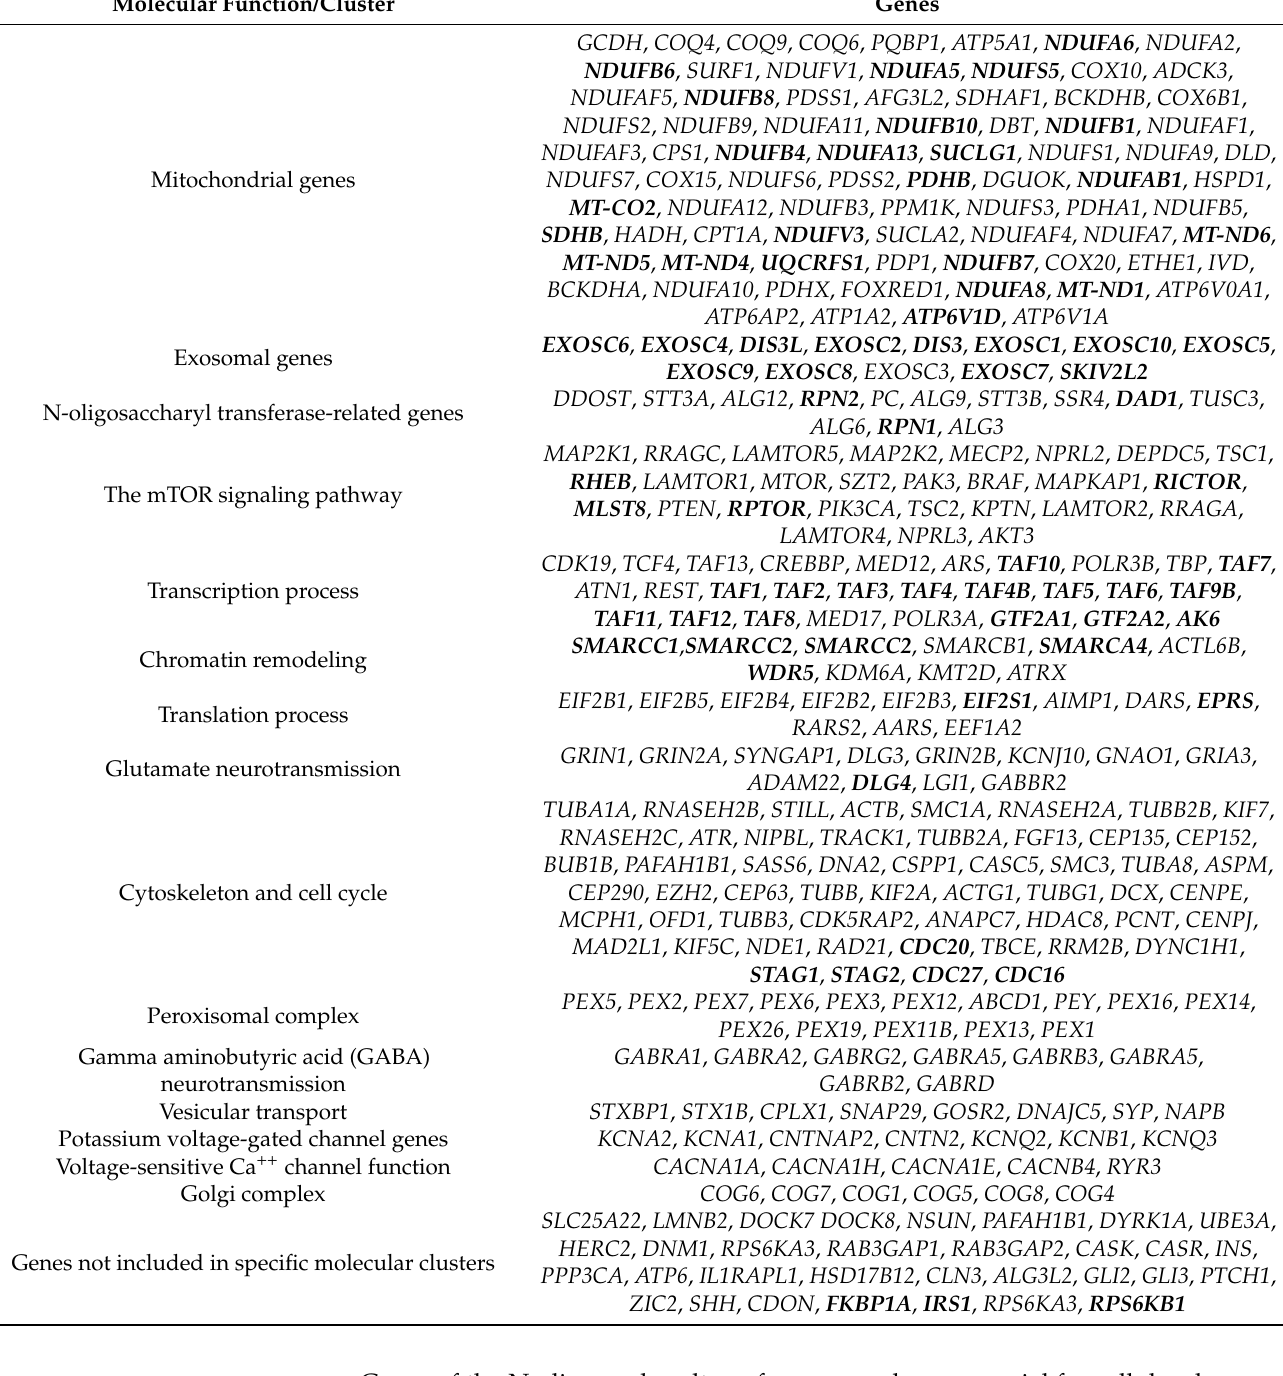
Table 3. Epilepsy-related genes analyzed in the present study and their clustering within a complex molecular network. Bolded genes listed here were absent in the original list of epileptic genes selected for our analyses here (see above), but have been identified by the STRING database, hence representing potential novel molecular